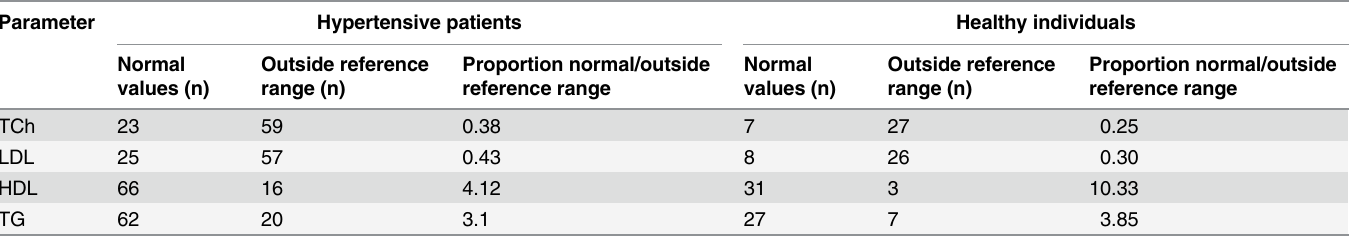
Table 2. Characteristics of the plasma lipidogram.